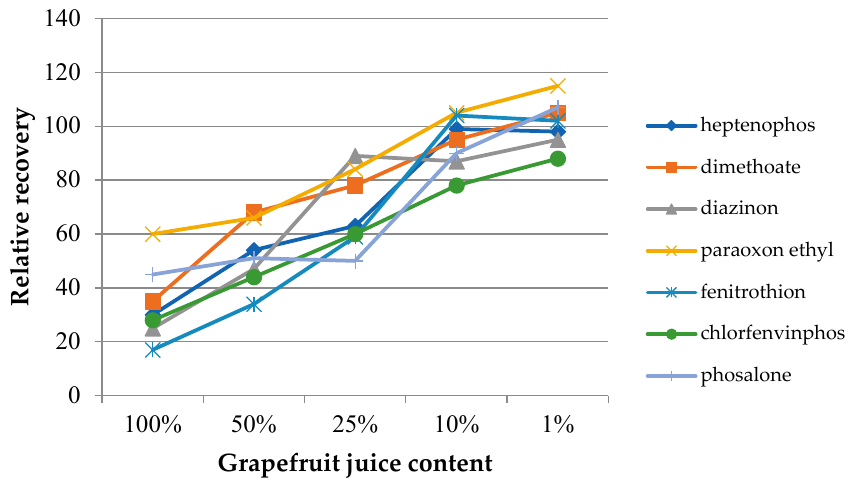
Figure 6. Effect of diluting the samples with ultrapure water at different dilution ratios ( v / v ) utilizing the IL-2 fiber for the extraction of grapefruit juice.